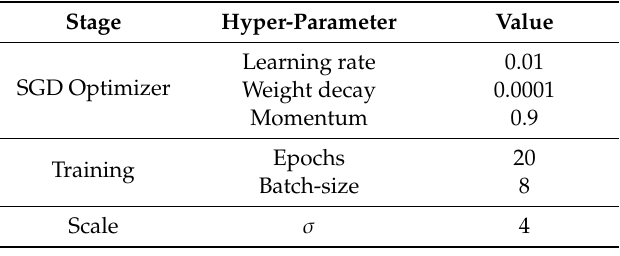
Table 3. The hyper-parameters